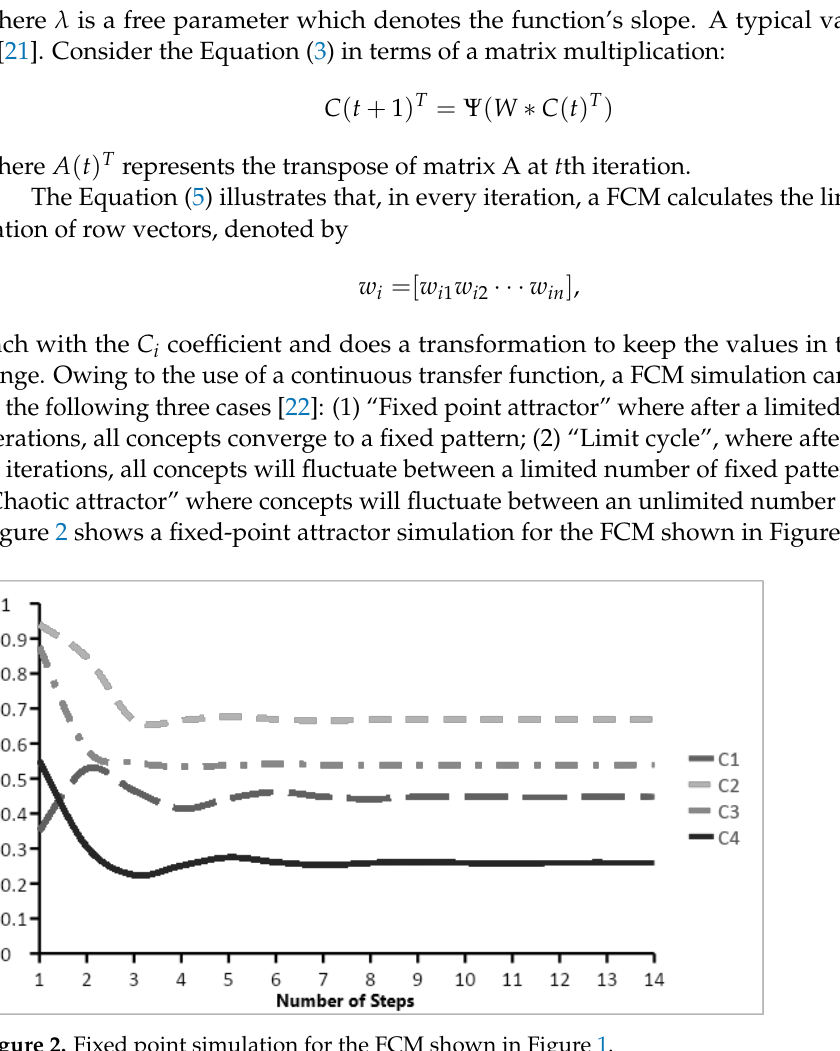
Figure 2. Fixed point simulation for the FCM shown in Figure